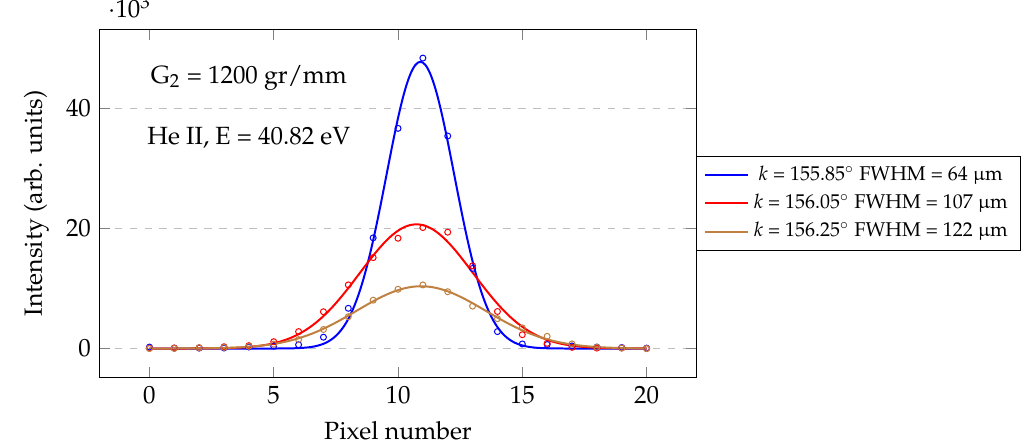
Figure 5. Line profile for k variation of 0.2 ◦ and 0.4 ◦ at 40.82 eV, G 2 grating.